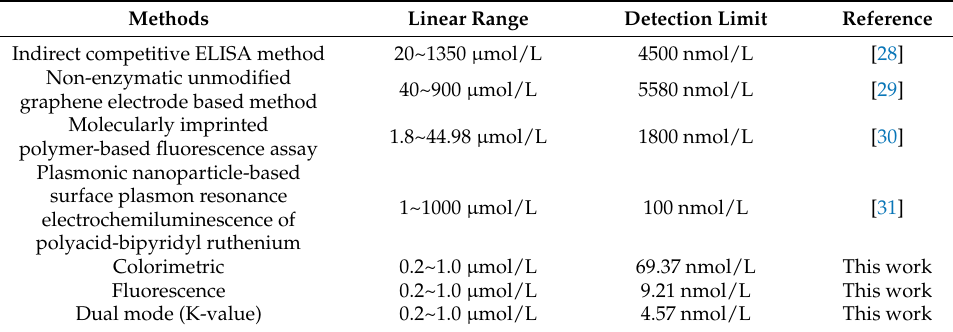
Table 3. Comparison of different histamine detection methods.